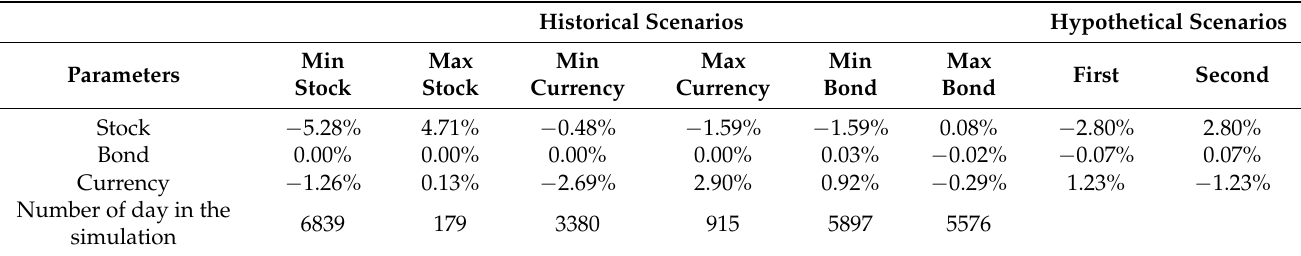
Table 6. An example of the stress